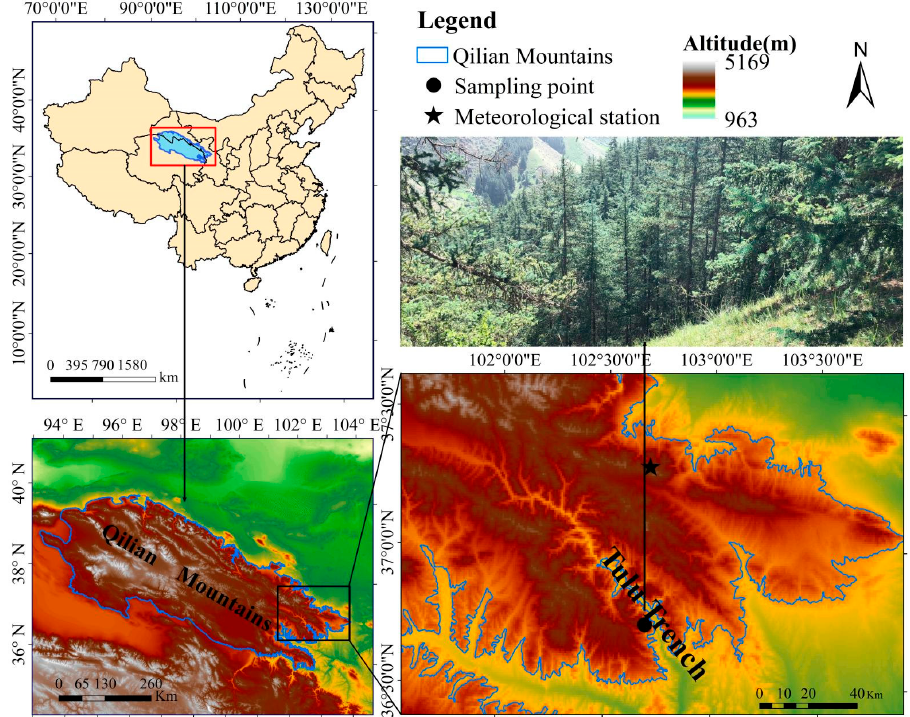
Figure 1. Locations of sampling sites and the nearest meteorological station (Wushaoling meteorological station).